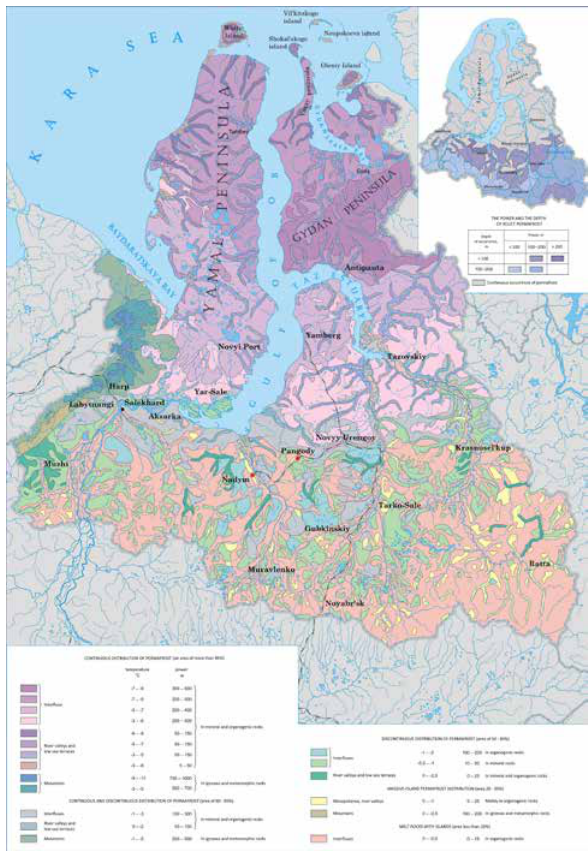
Figure 1: Location of the study